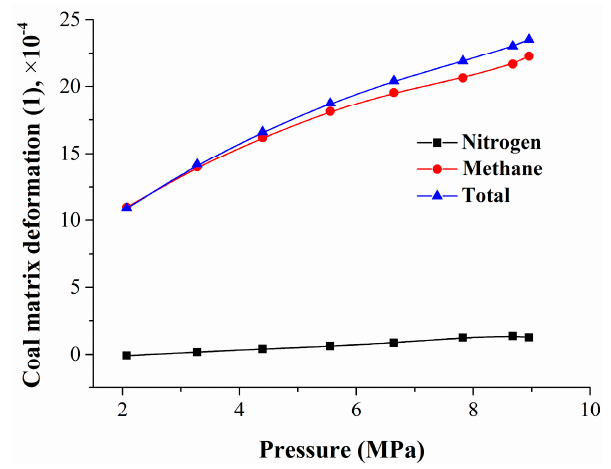
Figure 6. Relationship between coal matrix deformation and pressure.